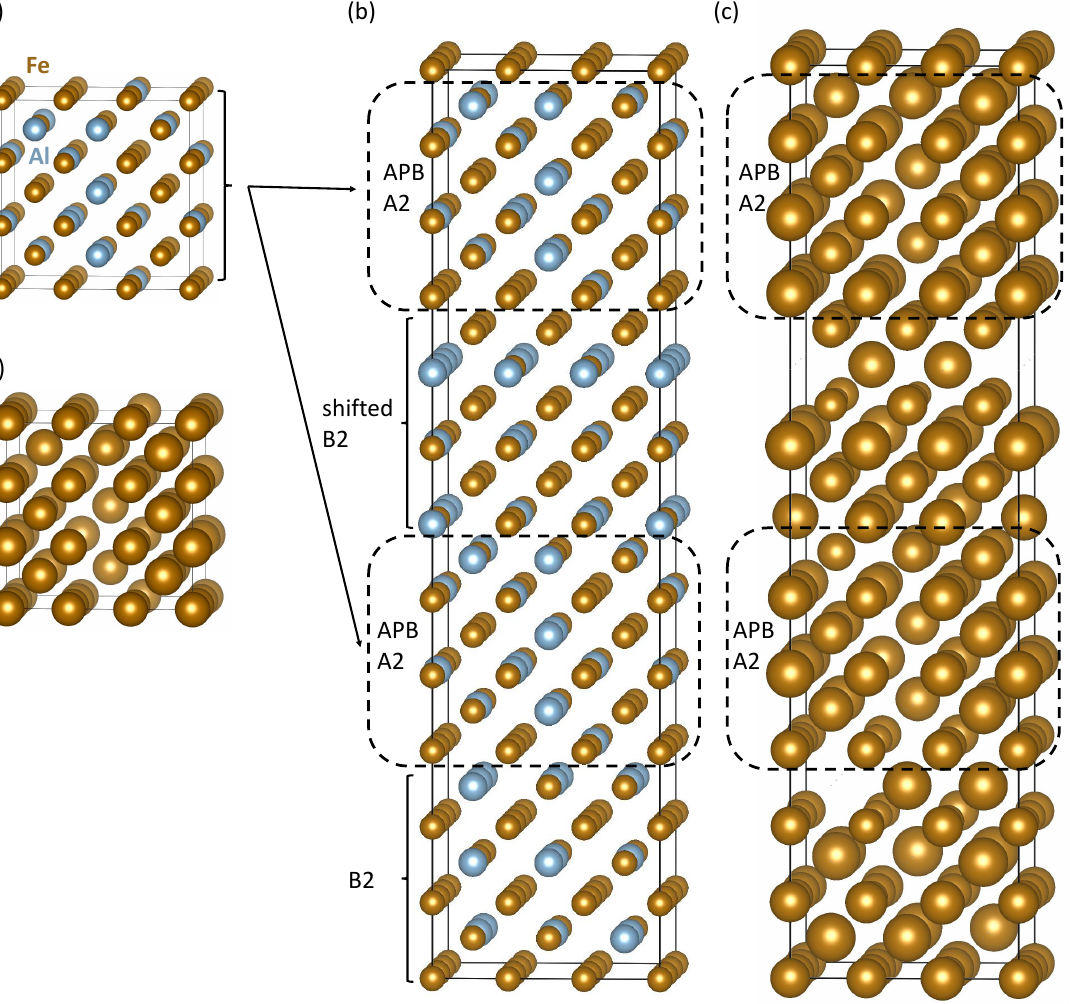
Figure 5. Schematic visualizations of thermal APBs in Fe 70 Al 30 alloy. A 54-atom supercell in part ( a ) is a 3 × 3 × 3 multiple of 2-atom body-centered cubic (bcc) elementary cell and represents our model for a perfectly disordered A2 phase of Fe 70 Al 30 . It consists of atomic planes containing both Fe and Al atoms distributed according to the SQS concept. Two of these 54-atom A2-phase supercells are introduced at each of the two sharp APBs in the supercell shown in Figure 1b to form the calculated thermal APBs. The computed local magnetic moments of atoms in supercells ( a , b ) are shown in parts ( c , d ), respectively. The magnitude of local magnetic moments are visualized by the diameter of spheres representing atoms—the scaling is the same as in Figures 1 and